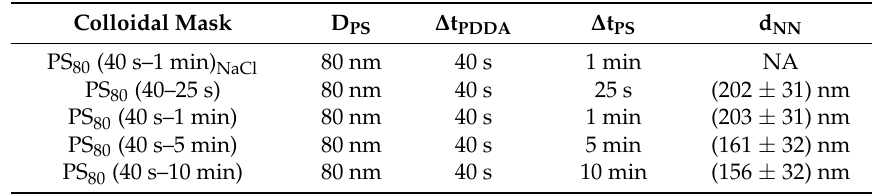
Table 1. Colloidal masks deposited by colloidal lithography with the corresponding experimental details and available results of the statistical